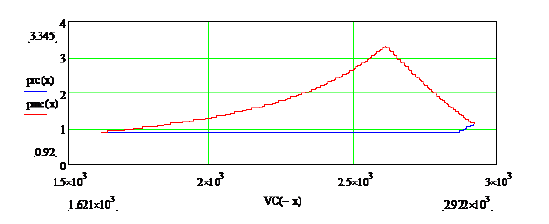
Figure 5. The indicated diagram for the compression